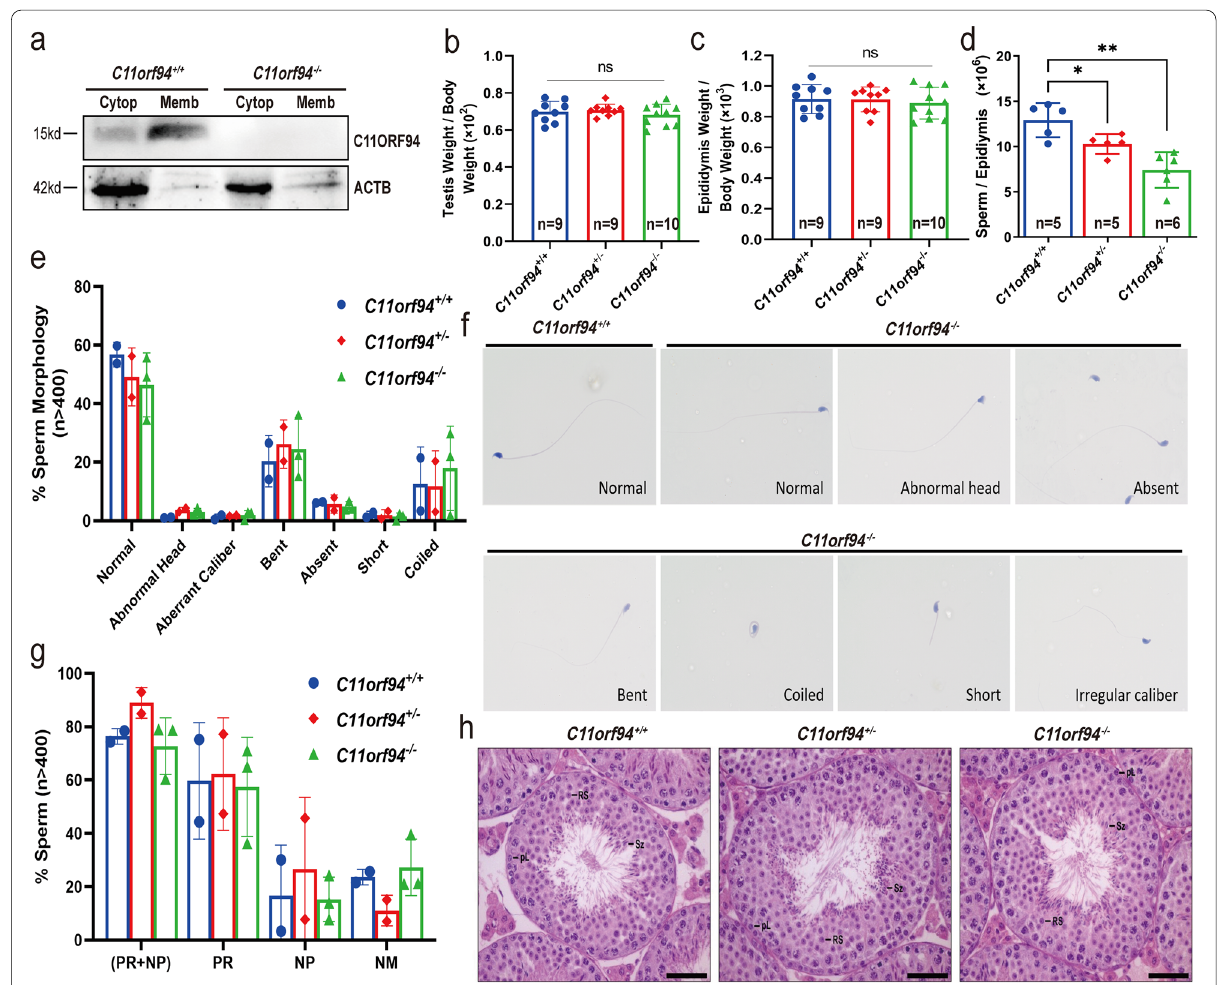
Fig. 3 Analysis of male reproduction in C11orf94 −/− male mice. a Western blot analysis of C11ORF94 protein levels in testis of C11orf94 − / − and wild type mice. b - c Testis or epididymis weight/body weight. There was no significant difference between C11orf94 + / + and C11orf94 − / − male mice. [testis weight/body weight: 0.7081 0.01052 ( C11orf94 ± , n 9), 0.6815 0.01849 ( C11orf94 − / − , n 10); epididymis weight/body weight: ± = ± = 0.9129 0.02722 ( C11orf94 ± , n 9), 0.8891 0.03275 ( C11orf94 −/− , n 10)]. ns: no significance. d Quantitative analysis of mature sperms in ± = ± = the cauda epididymis of mice. This showed significant and extremely significant differences when comparing the C11orf94 −/− to C11orf94 ± or C11orf94 − / − groups (*, p < 0.05; **, p < 0.01). e – h Analysis of sperm motility (PR NP) using CASA. There was no significant difference in sperm + motility among different genotypes of mice. [47.24 17.56, ( C11orf94 ± , n 4); 43.13 13.26, ( C11orf94 ± , n 4), sperms number > 400]. RP: ± = ± = Progressive motility; NP: Non-Progressive. ns: no significance. f - g Analysis of the morphology of mature sperms by HE staining. f is a representative diagram of various sperm morphology. h HE staining reveals the morphology of spermatogenesis in testis of different genotypes of mice. Pl: preleptotene; Rs: round spermatid; Sz: spermatozoa. Scale bar, 100